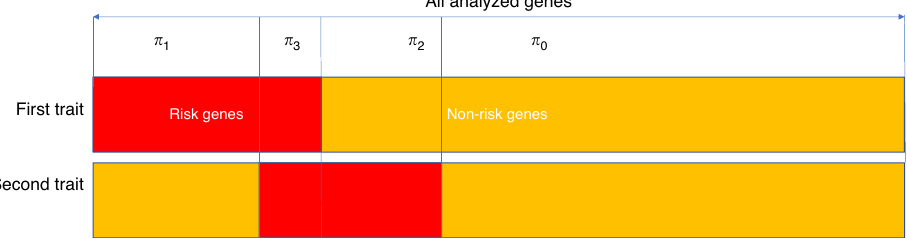
Fig. 1 The multiple trait transmission and de novo association test (mTADA). For each trait, mTADA divides the all tested genes into two sets: risk and non-risk genes. Therefore, there are four sets when two traits are combined: risk genes for neither of traits (H 0 ), for the fi rst trait only (H 1 ), for the second trait only (H 2 ), and for both traits (H 3 ). Statistical details of four models for these four hypotheses are described in Table 1. π j ( j = 0..3) are prior probabilities for the four models. From mTADA ’ s analysis results, each gene has four posterior probabilities (PPs) of the four models (e.g., PP0, PP1, PP2 and PP3 for Model 0, Model 1, Model 2 and Model 3